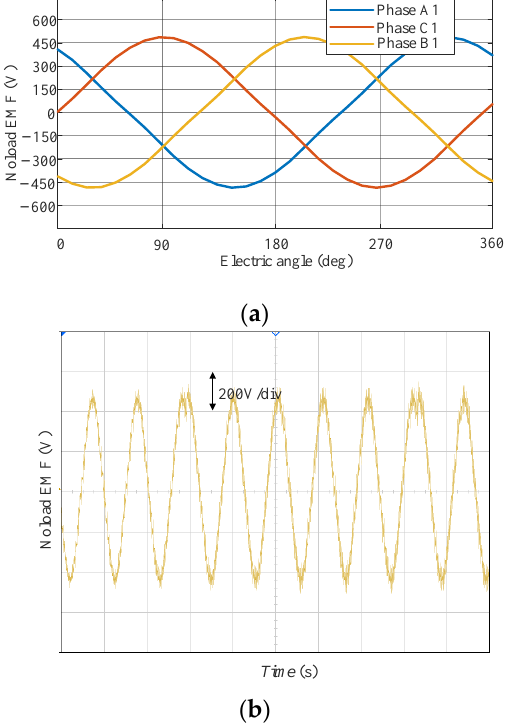
Figure 12. 36-slot/34-pole FSPM generator a set of three-phase (A1, B1, C1) No-load Back EMF @ 600 r/min: ( a ) Simulated. ( b ) Measured.